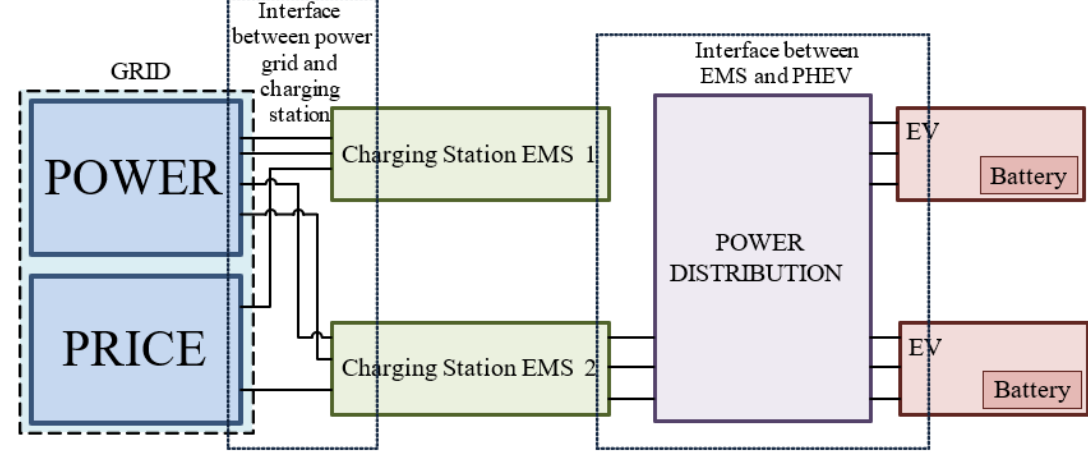
Figure 5. Architecture of the intelligent energy management system.